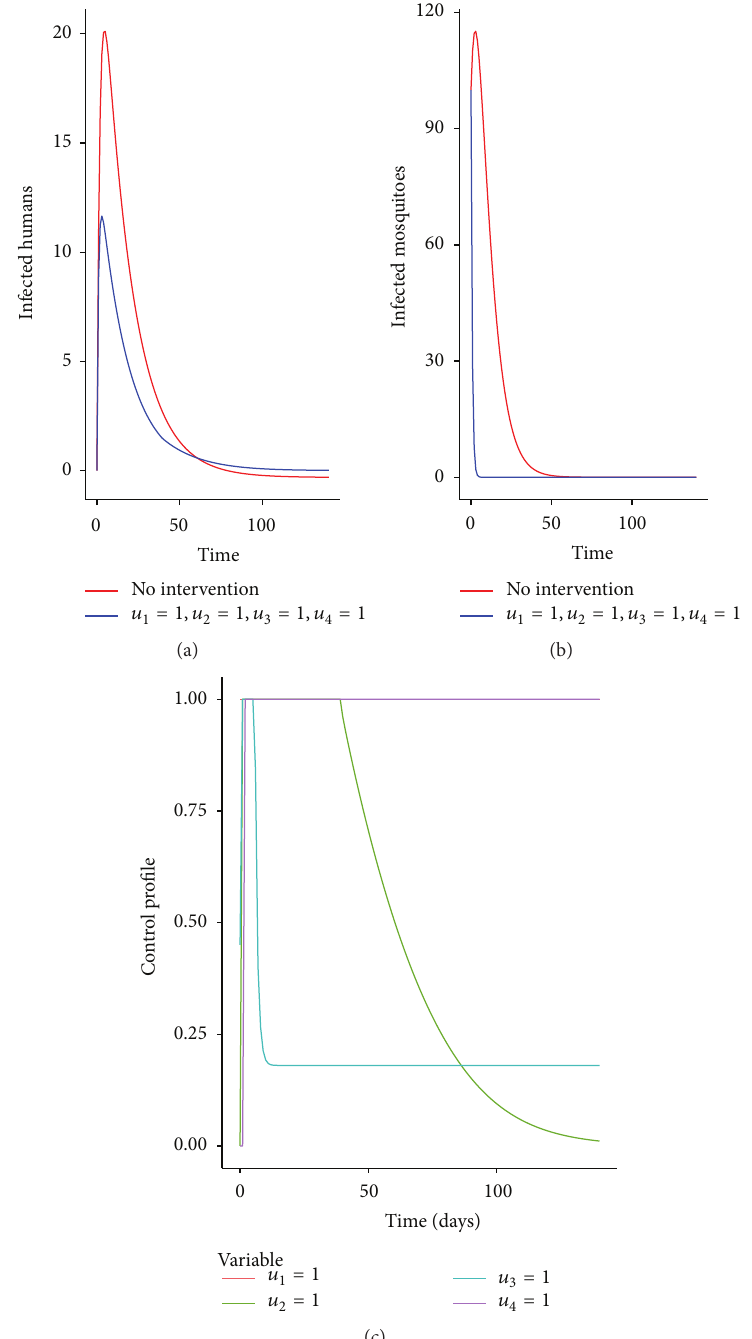
Figure 6: Simulations of the model showing the effect of ITNs, treatment, IRS, and IPTp on the spread of malaria for the endemic setting.